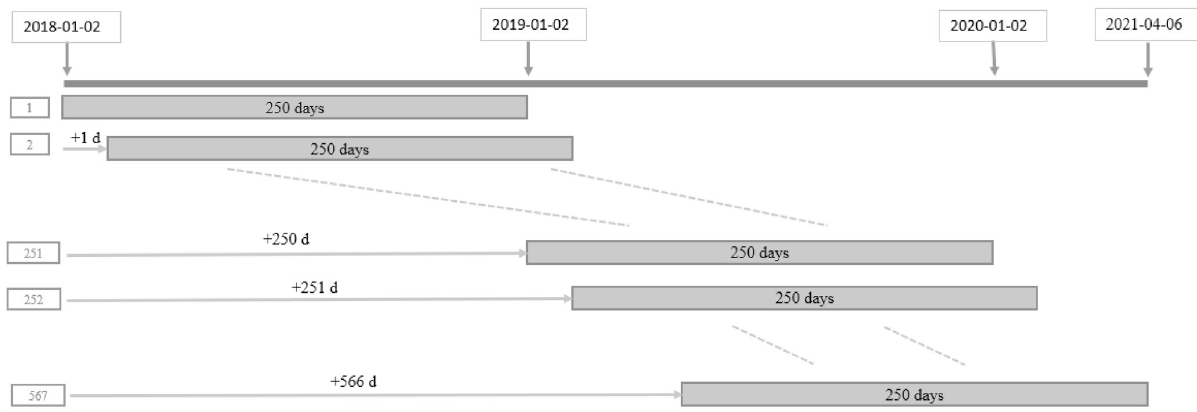
One can guess that a true change point occurs on 2019/12/24 as the COVID-19 outbreak began at that time and triggered a sudden change in the global financial market resulting in a plunge of crash in stock prices. To examine this, the three tests are conducted. The result shows that T UCL detects a change point most quickly on 2020/01/10, while both T and T scale max s max detect the change point on 2020/06/11, which is quite late compared to the first test. See Fig 13. The second change point is claimed to be on 2020/03/30 as the price of Brent crude oil fell 9% at the date to US $23 per barrel which was the lowest price since 2002. As all ships in BDI needed oil to travel, the abnormality of Brent crude oil led to trigger a serious BDI change. In this case, T UCL , T scale , and T appear to detect a change point on 2020/04/14, 2020/05/15, and max s max 2020/06/11, respectively. See Fig 14. This finding reveals that T UCL can detect a change about a half month after the occurrence s of such big events, a lot faster than T and T scale , which strongly affirms the validity of our max max proposed method when used in tandem with the rolling window scheme.